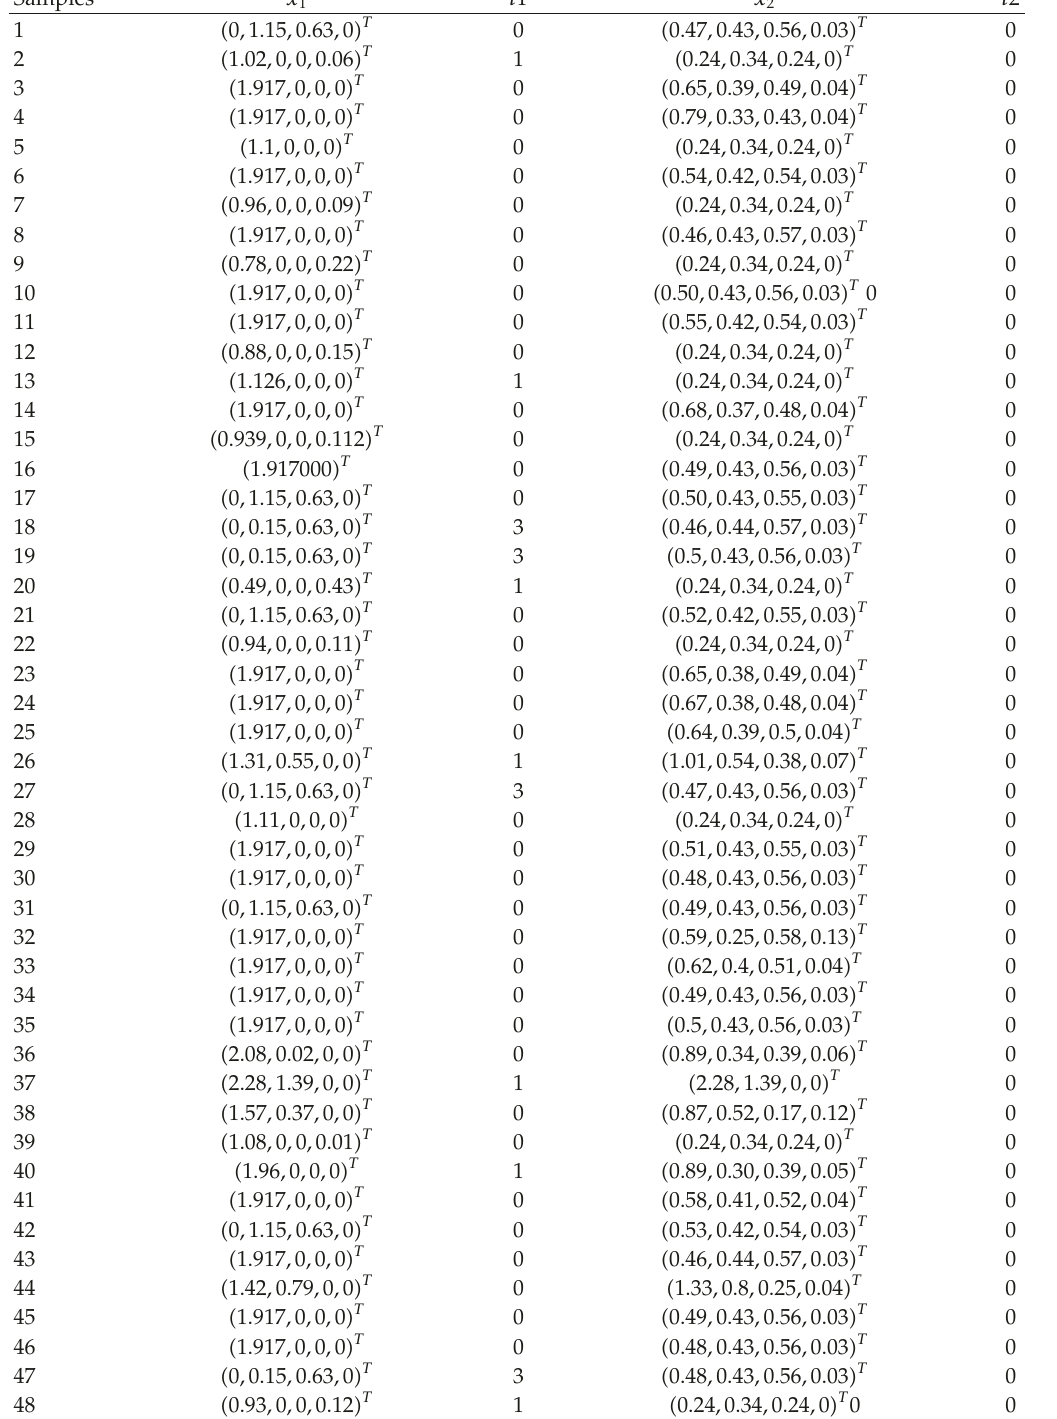
Table 2: Comparison between expectation method and hybrid